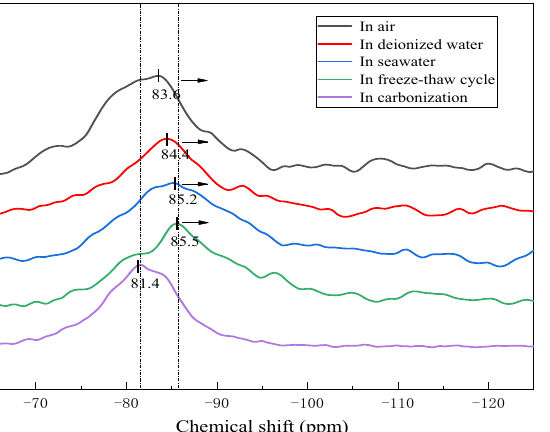
Figure 5. 29 Si NMR spectra of the geopolymers prepared with 60% BFS subjected to different exposures.